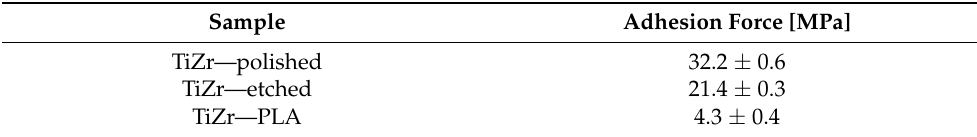
Table 2. Adhesion forces for the obtained samples.